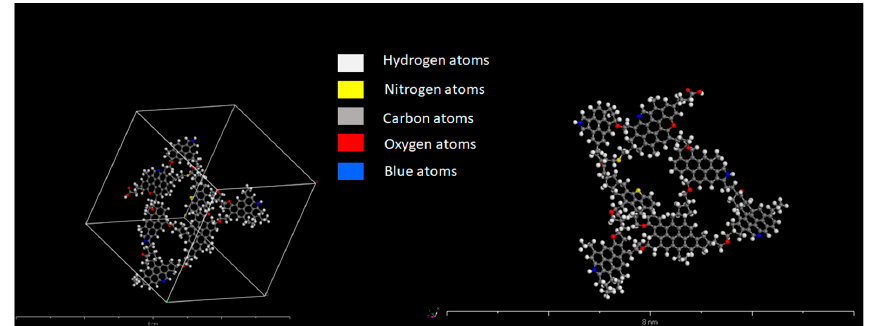
Figure 1. Type II-C kerogen structure; the formula is C 242 H 219 0 13 N 5 S 2 .